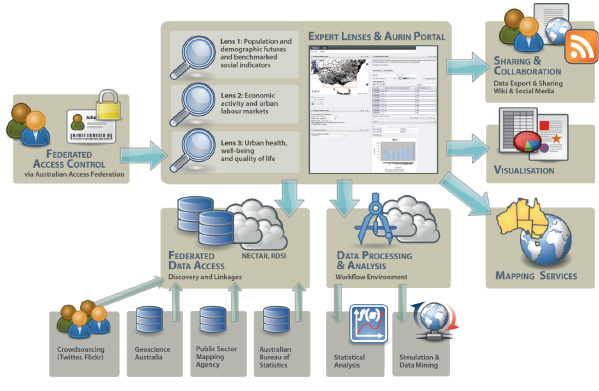
Figure 1: AURIN workbench: an open-source federated technical architecture Source: Sinnott et al.